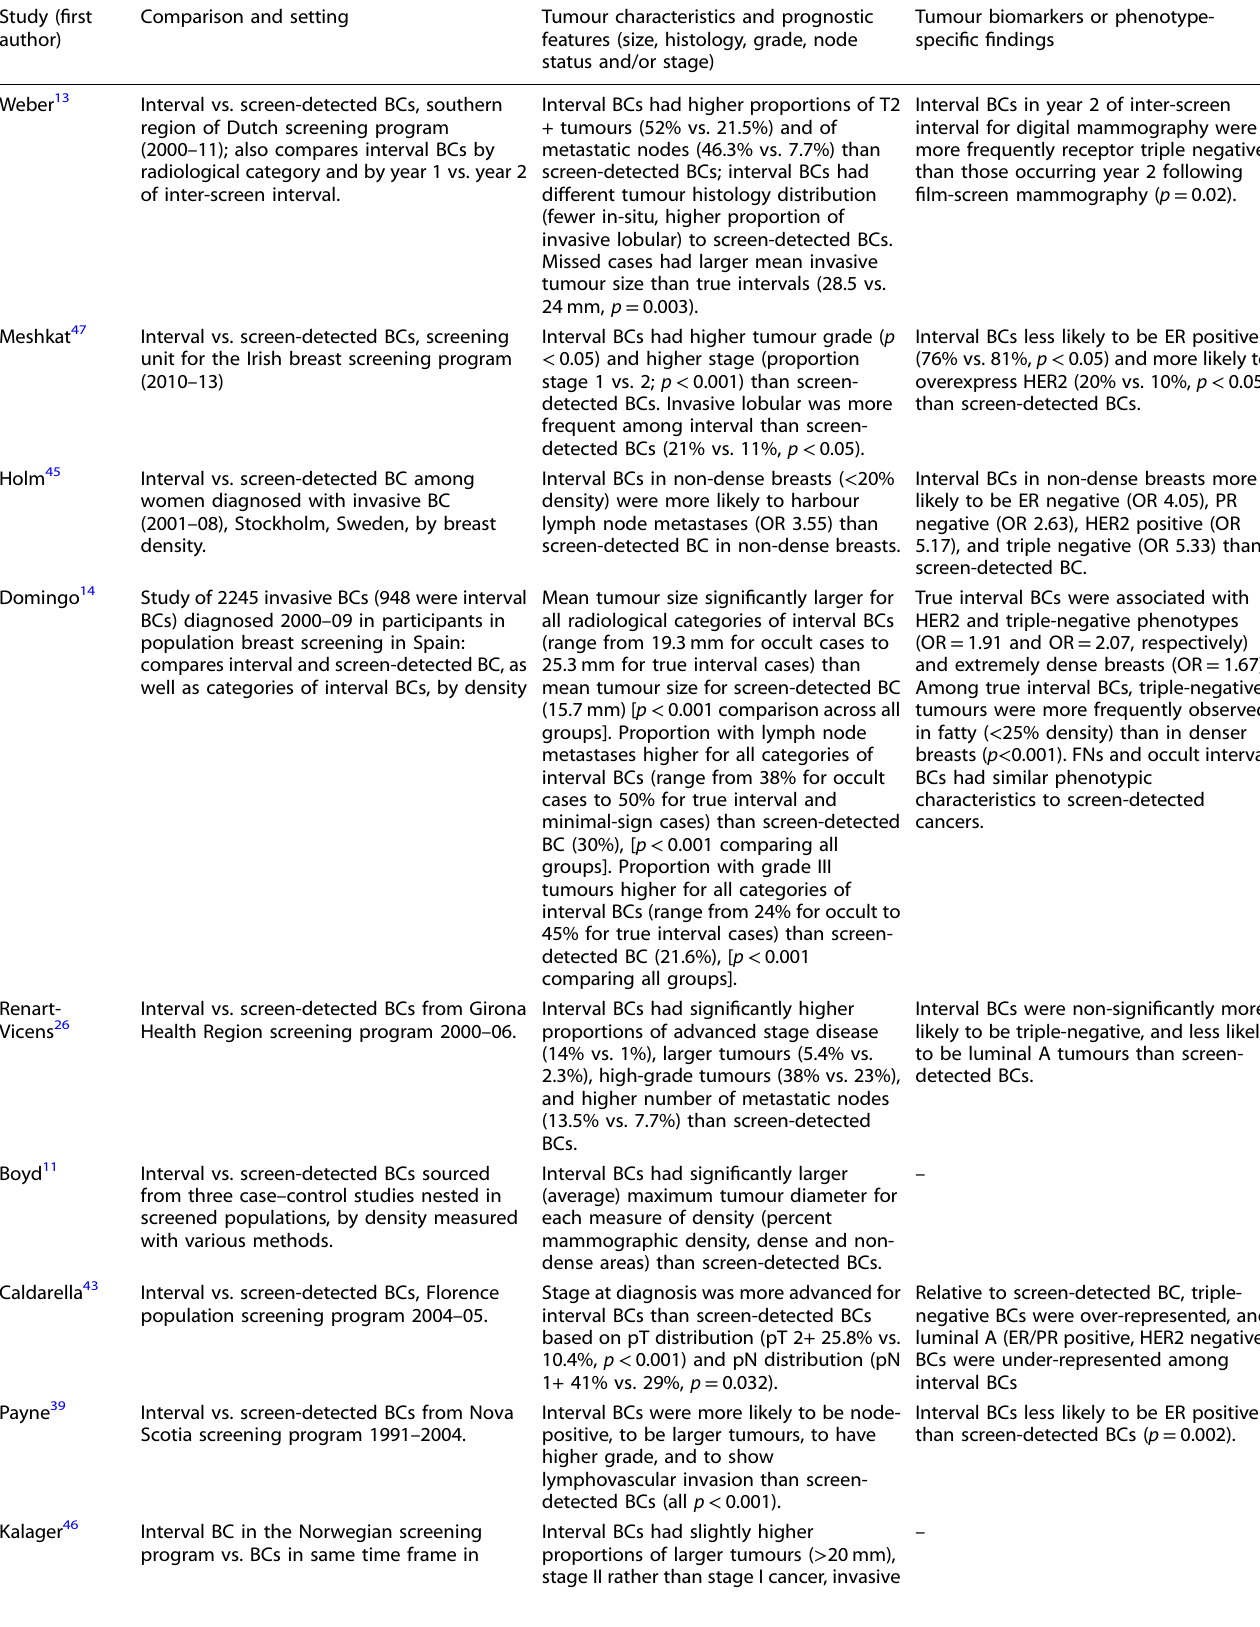
Table 3. Biological characteristics of interval breast